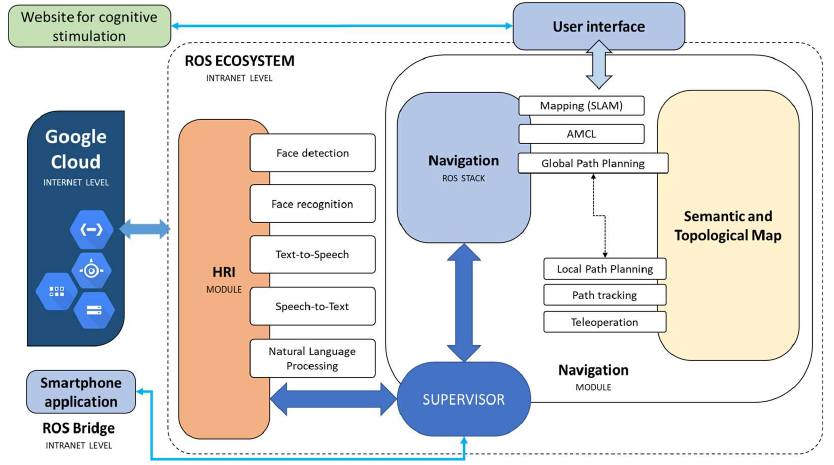
Figure 2. Diagram with all the components included in the whole software architecture.